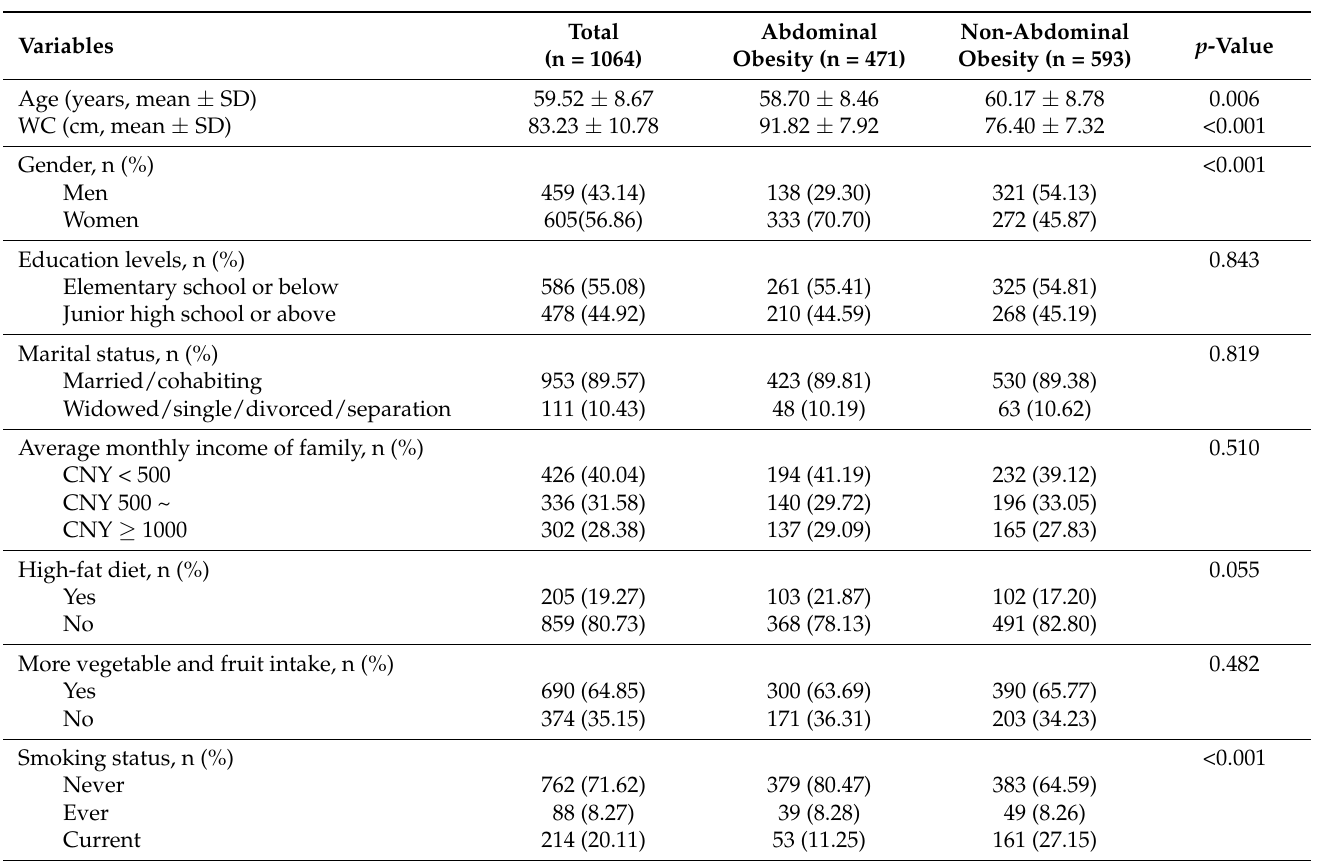
Table 1. Distributions of characteristics of the participant by with and without abdominal